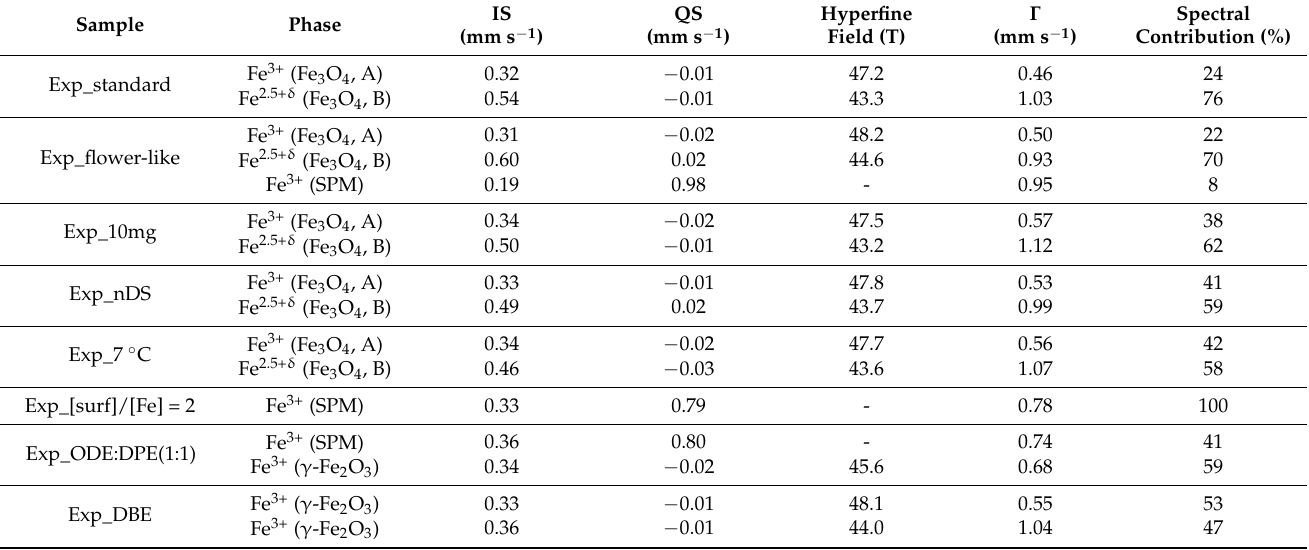
Table 4. The Mössbauer fitted parameters of Pd/Fe-oxide NPs at 300